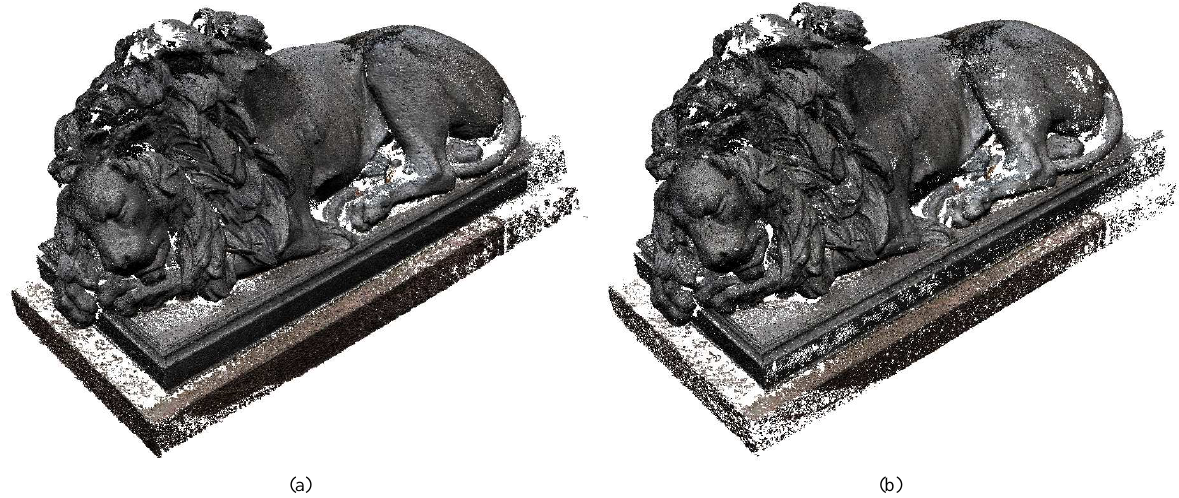
Figure 4: Resulting oriented points of the lion data set. (a): RQT error threshold ǫ = 1 . 0 . (b): RQT error threshold ǫ = 1 . 2